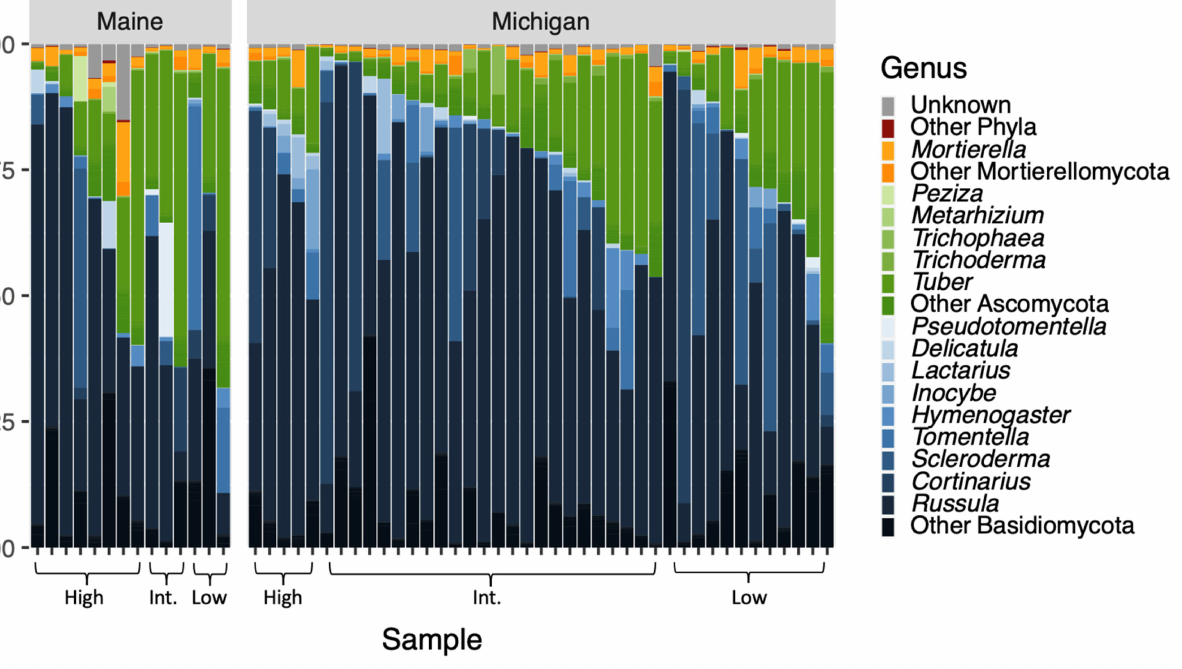
Figure 2. The relative abundances of OTUs of fungal genera within the three most prominent phyla are plotted according to tree provenance and BLD symptom severity. In this plot, phyla are represented by different colors and genera within those phyla are shades of those colors. Our sequencing effort yielded 1,178,687 reads across 677 OTUs. Analysis of community composition elucidated that fungi were significantly different between the tree provenances ( F = 2.1538; p =